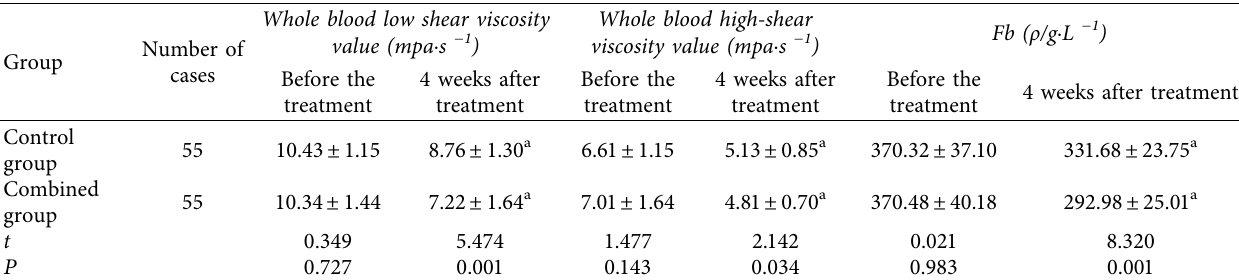
Table 3: Comparison of plasma viscosity between the two groups ( n , x ± s